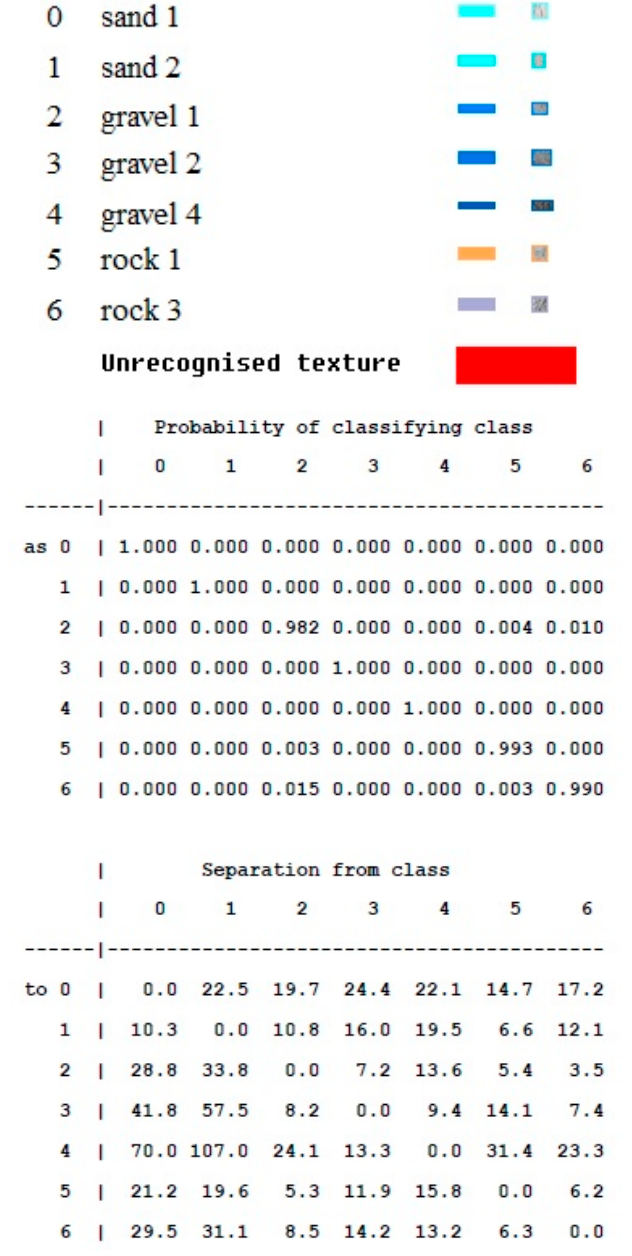
Table 2. Top: Seabed image textures for the three-frequency colour reduced to greyscale sonar image selected during a user-supervised image texture characterisation process. These were subsequently used to generate the classified image (Figure 5). Bottom: A matrix of the probabilities of classifying one class as another; and a matrix of class separations (in standard deviations) computed for the image texture characteristics extracted from the colour reduced to greyscale backscatter image.